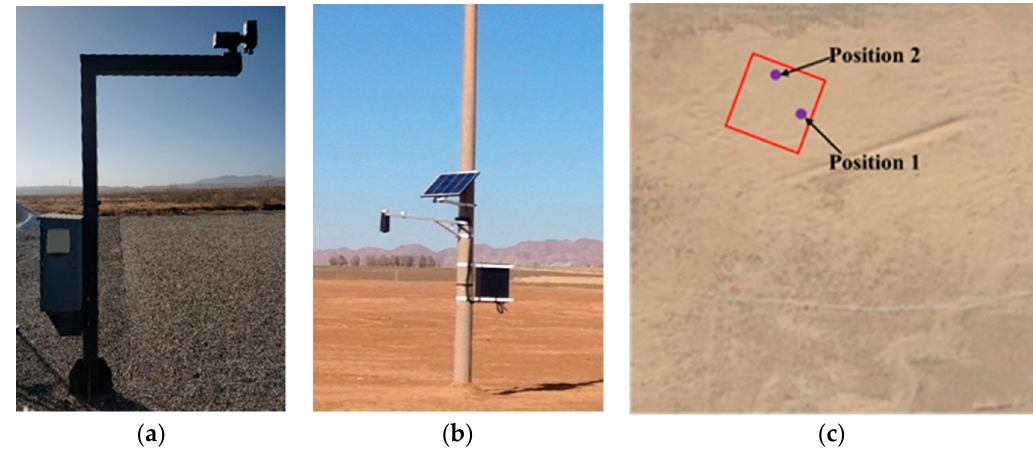
Figure 2. Automatic observation systems of ground reflected radiance in the Baotou site. ( a ) Observation system on grey target; ( b ) observation system on sandy site; ( c ) the positions of the two spectrometers on sandy site.